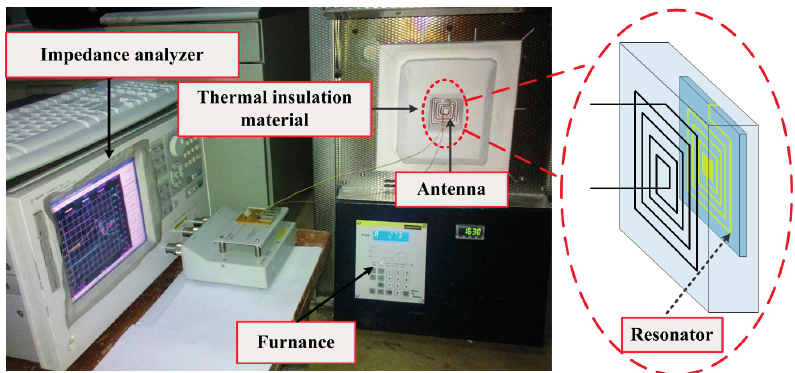
Figure 6. Experiment setup for the LC